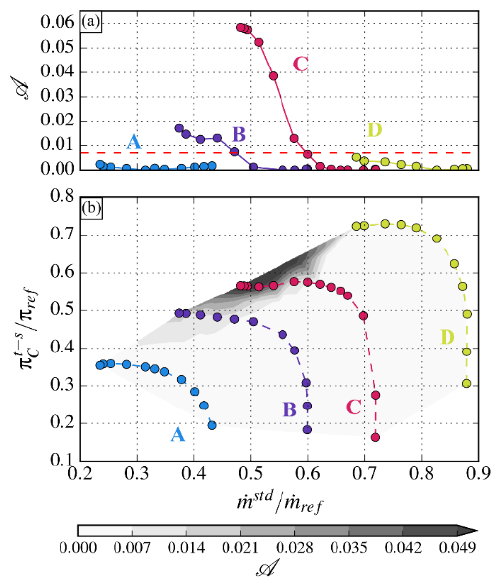
Figure 7. Experimental alternate rate at different rotation speeds of the compressor: ( a ) Evolution of the alternate rate versus the reduced mass flow; ( b ) The alternate rate superimposed on the performance map of the compressor.